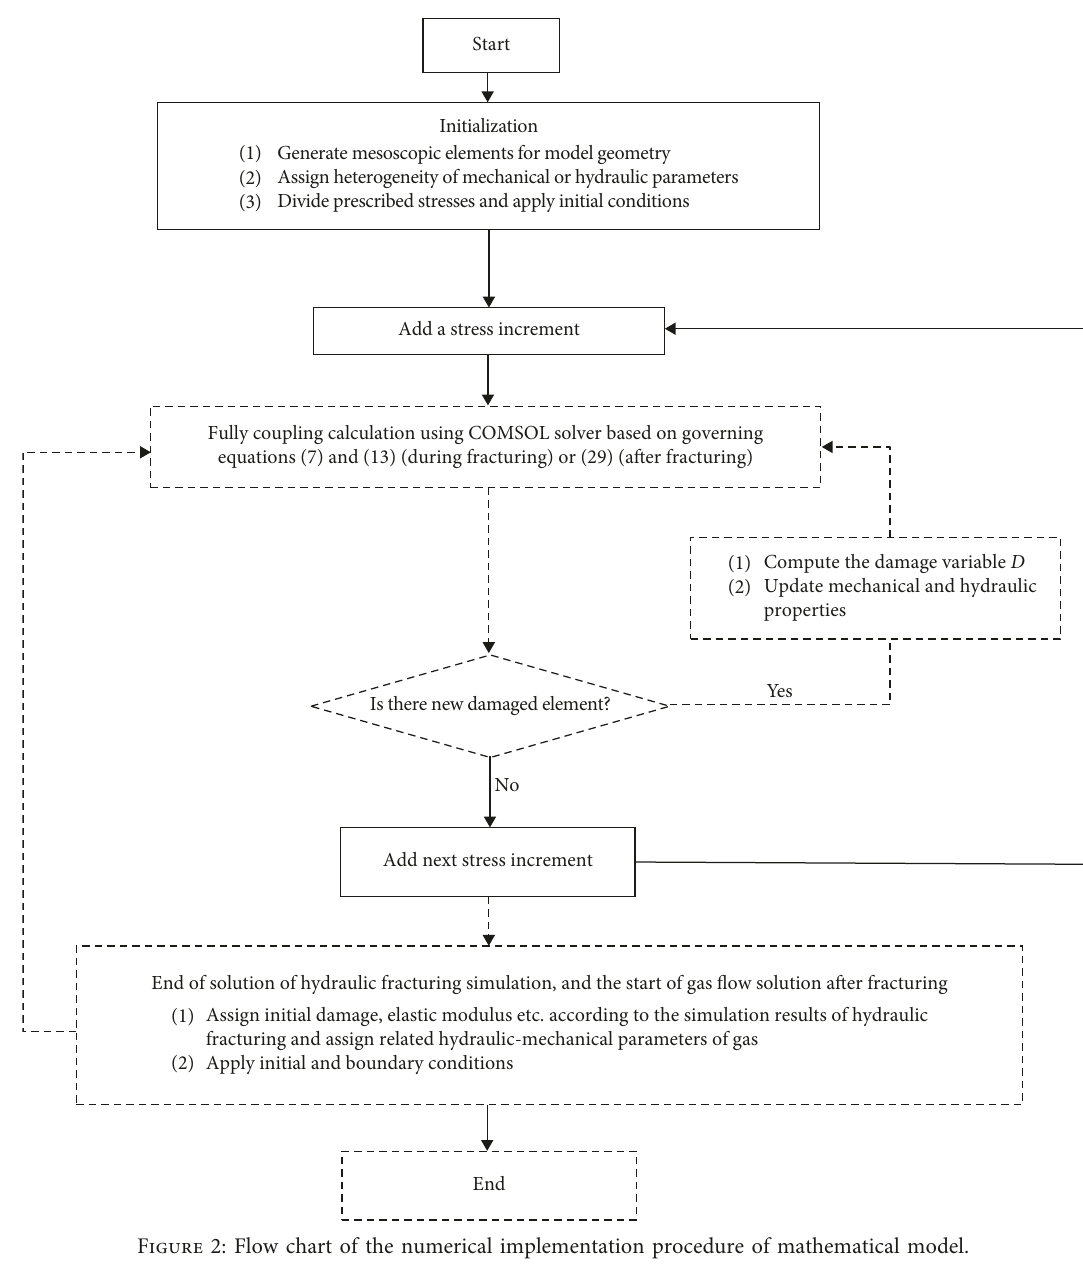
Figure 2: Flow chart of the numerical implementation procedure of mathematical